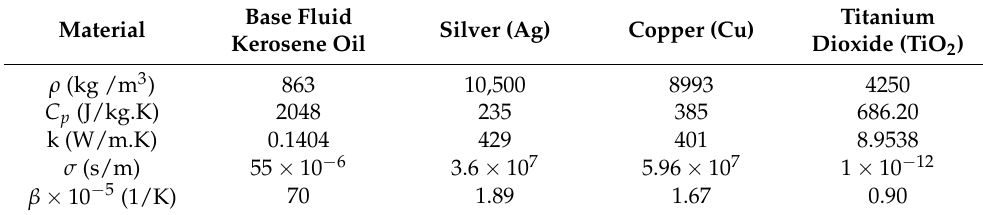
Table 1. Thermophysical possessions of nanoparticles and base fluid [48].